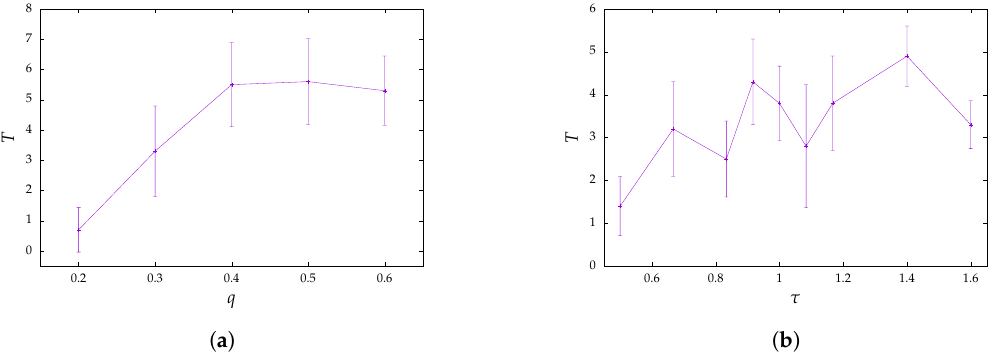
Figure 3. Comparison of termination time T in hops between probabilistic flooding and the SIR epidemic model: ( a ) probabilistic flooding termination time T by probability q ; ( b ) SIR epidemic model termination time T by reproduction number τ .